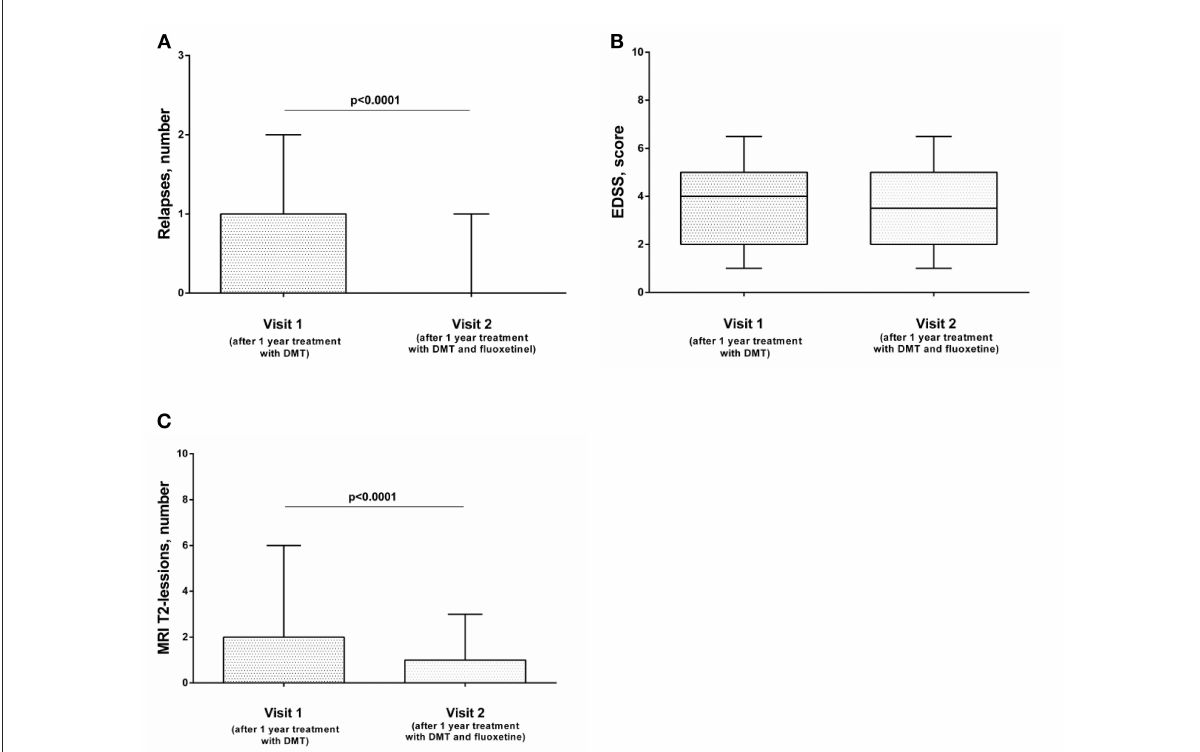
FIGURE1 The influence of combined therapy (DMT and fluoxetine) on the frequency of exacerbations (A) , EDSS score (B) , and MRI activity (C) of the disease in patients with relapsing–remitting MS ( n = 70). The Wilcoxon signed-rank test was used to compare two groups. Horizontal lines on the graphs correspond to the median and whiskers indicate to the min. and max values. The median values were compared and the p -values are indicated in the